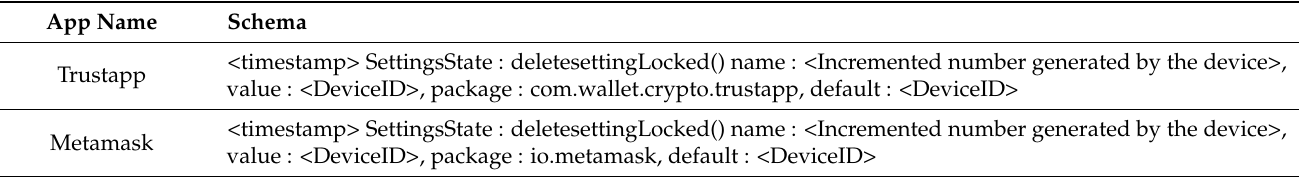
Table 7. Full-device IDs recovered for cryptocurrency wallets in the Android